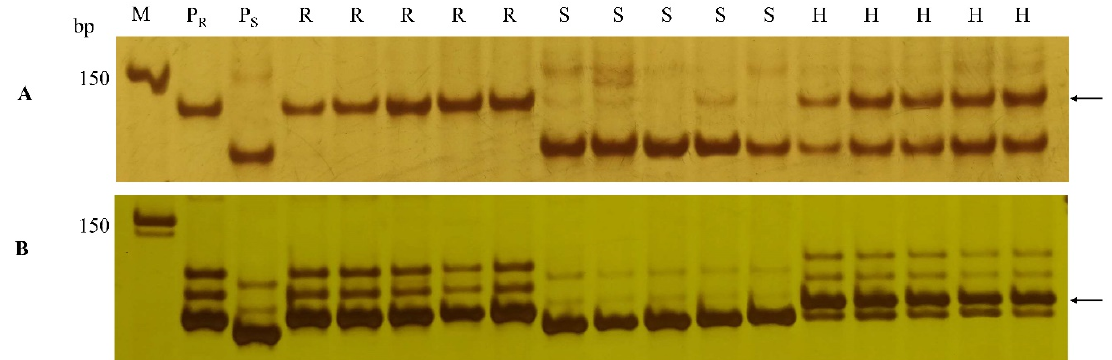
Figure 6. The banding patterns of Pm61 -linked simple sequence repeat (SSR) markers Xicscx497 ( A ) and Xicsx538 ( B ) in the parents and the selected F 2:3 lines of the Xuxusanyuehuang × Zhongzuo 9504 cross. Lane M, 50 bp DNA ladder; P R , Xuxusanyuehuang; P S , Zhongzuo 9504; R, homozygously resistant F 2:3 lines; S, homozygously susceptible F 2:3 lines; and H, heterozygous F 2:3 lines. Arrows indicate the polymorphic bands specific for Pm61 .